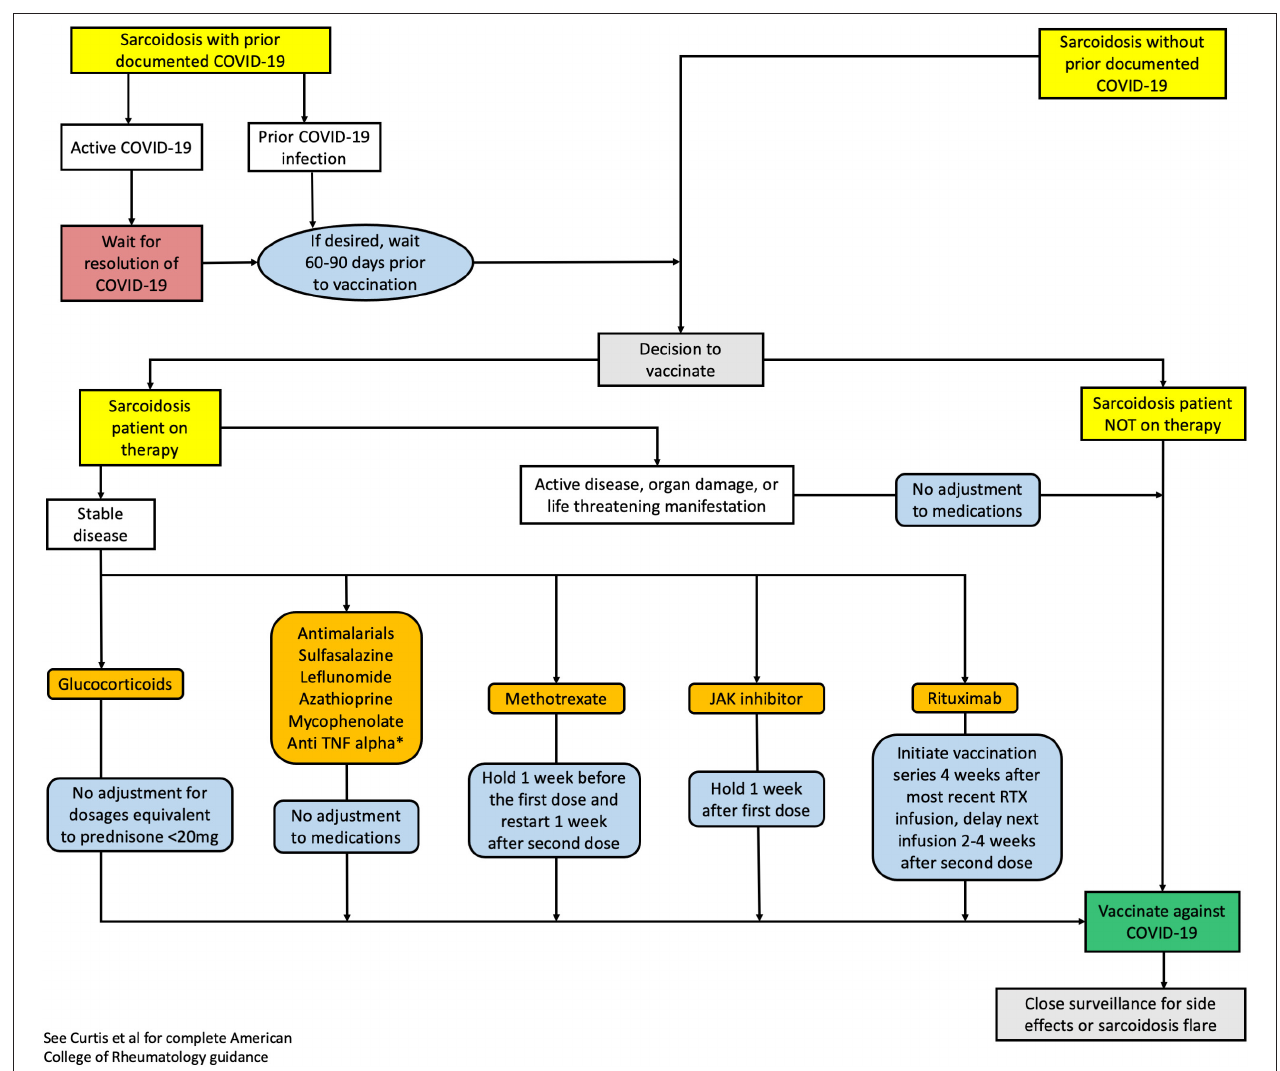
FIGURE 1 | Proposed clinical decision algorithm vaccination in sarcoidosis with or without prior COVID-19 infection. Recommendations are based on ACR guidance for COVID-19 vaccination in patients with rheumatic and musculoskeletal diseases (32) RTX, rituximab; TNF, tumor necrosis factor. *Current guidance recommends no adjustment in patients on anti-TNF alpha therapy. However, recent data suggests that in some patients on infliximab, the antibody response to SARS-CoV-2 may be blunted (33). At this time, it is unknown if this is applicable to sarcoidosis